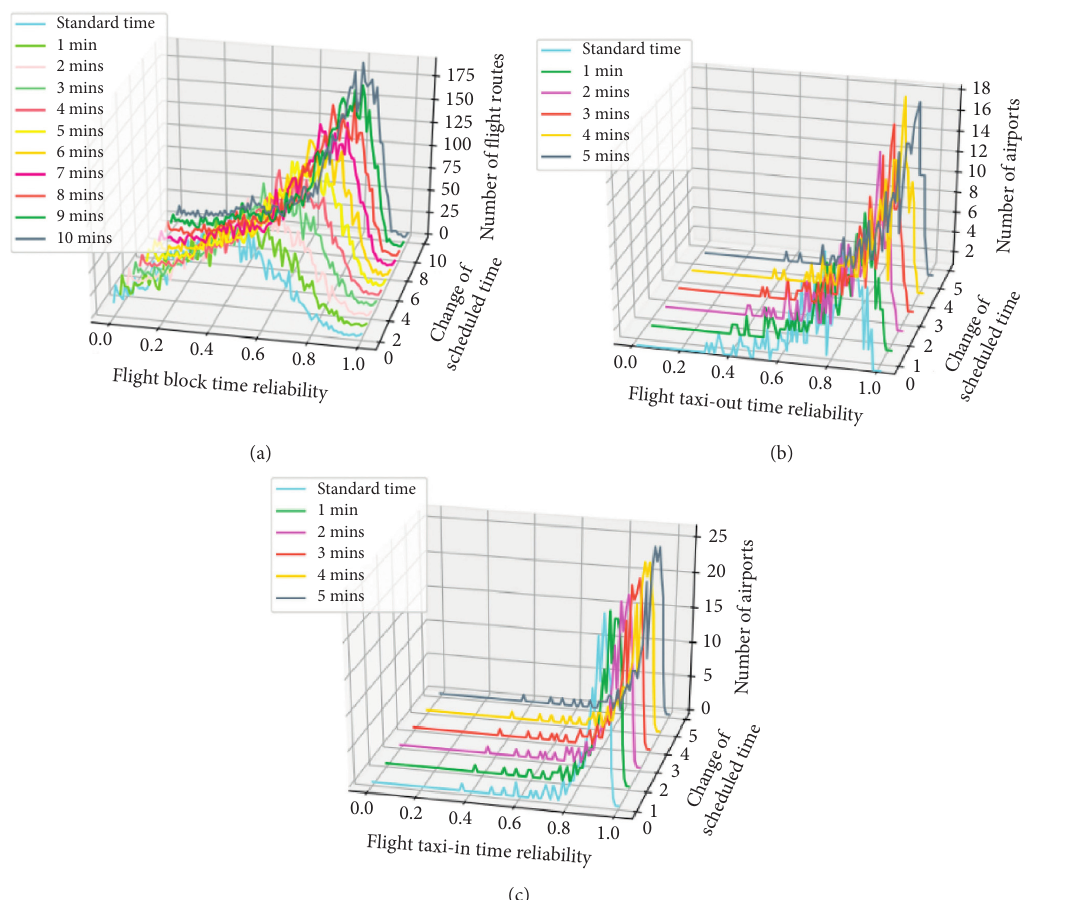
Figure 2: Reliabilities changes with different standard scheduled times. (a) Flight block time. (b) Flight taxi-out time. (c) Flight taxi in